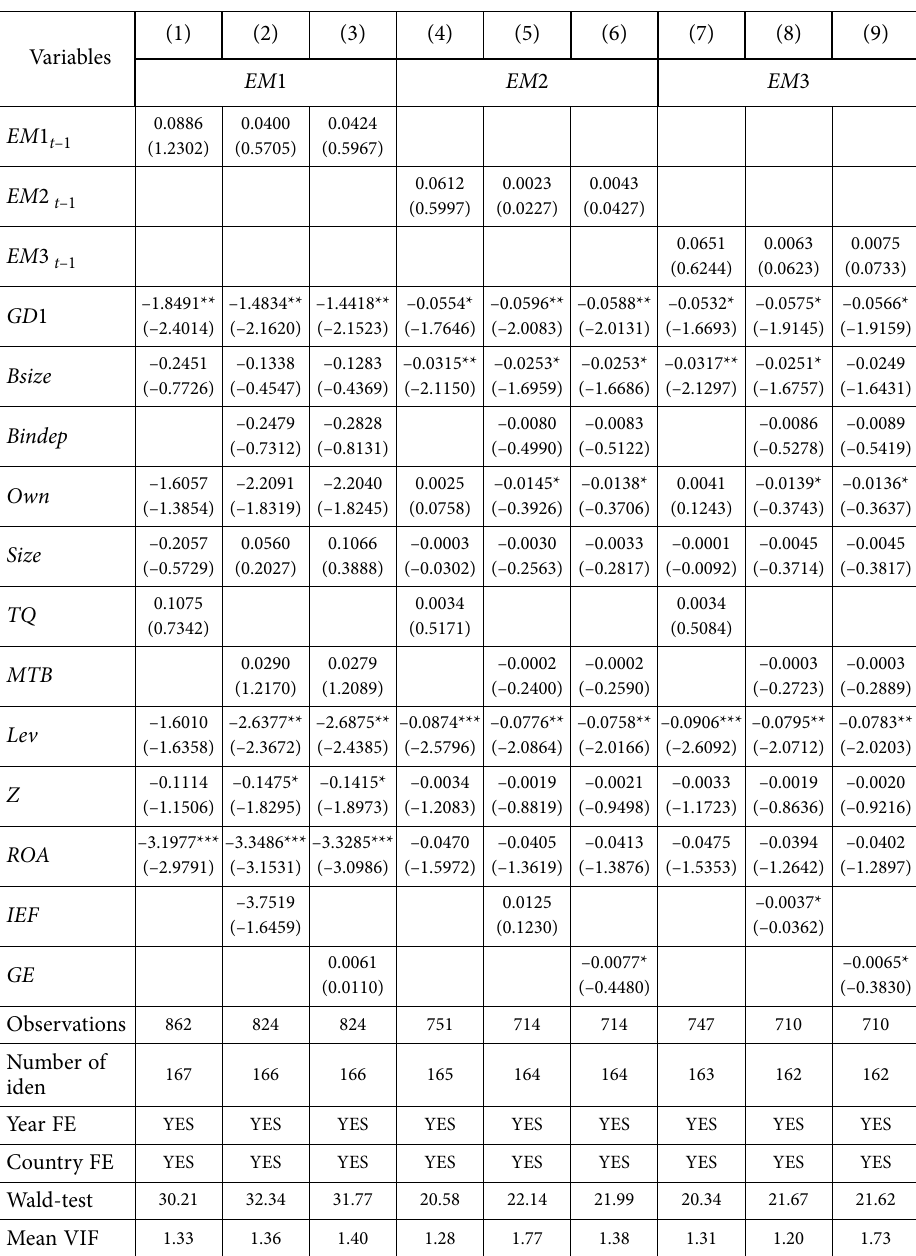
Table 6. Women on board and earnings management (GMM